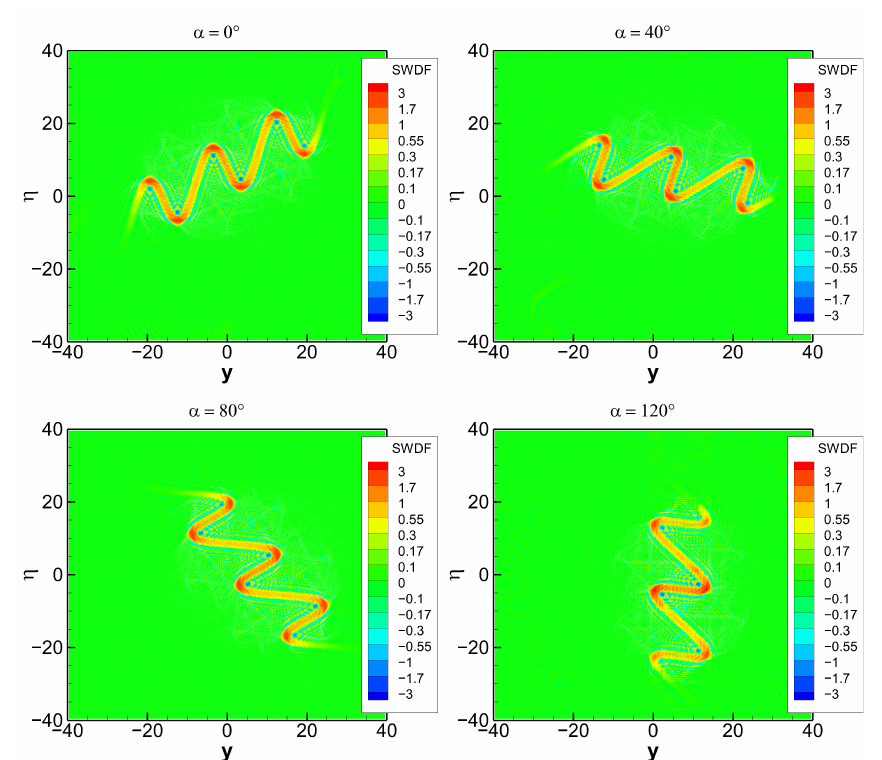
Figure 9. SWDF ρ WK α of function ˜ ψ α ( y ) in rotated coordinates ( y , η ) . The rotation angle α takes the values of 0 ◦ , 40 ◦ , 80 ◦ , and 120 ◦